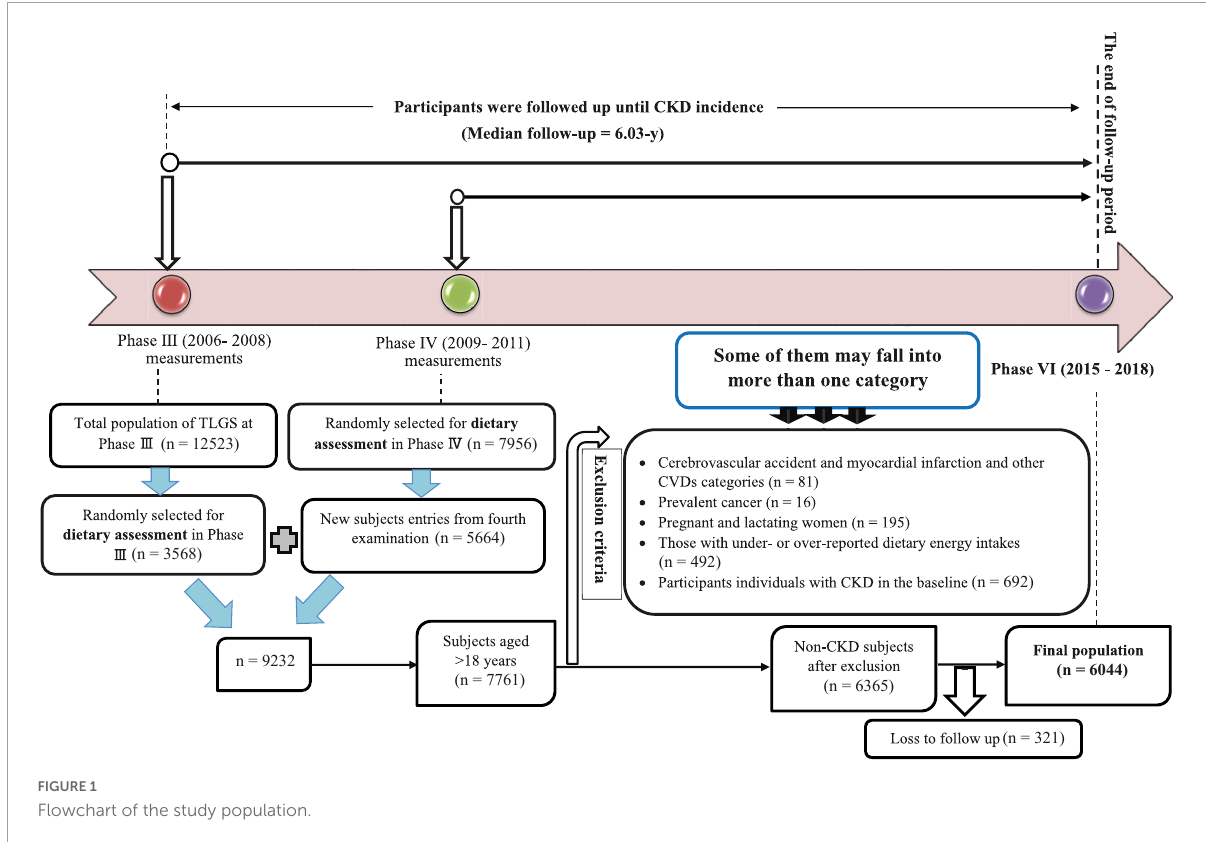
FIGURE1 Flowchart of the study